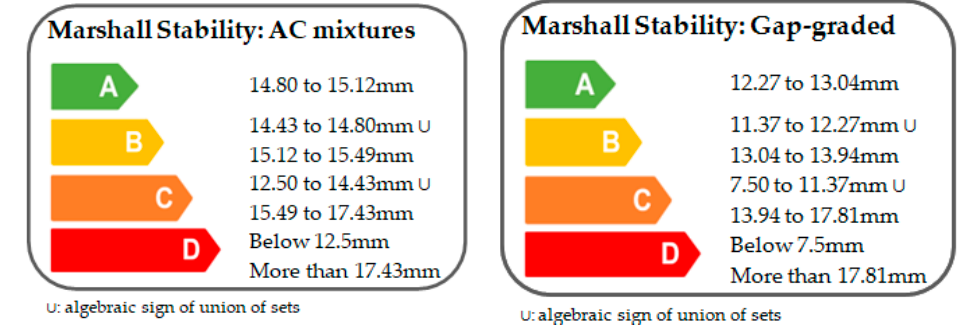
Figure 11. Marshall stability labels based on the type of mixture.